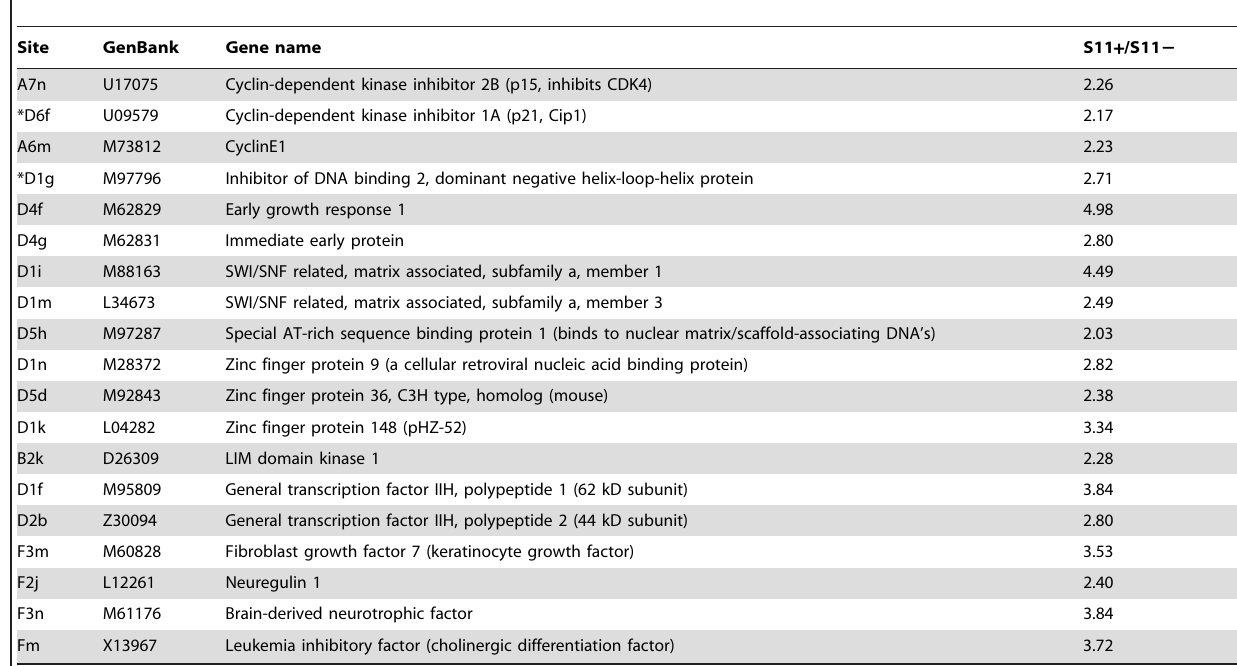
Table 2. Genes increased in Hep3B-tet on-FN1BP1/S11 cells induced by Dox (* selected to identify by RT-PCR).